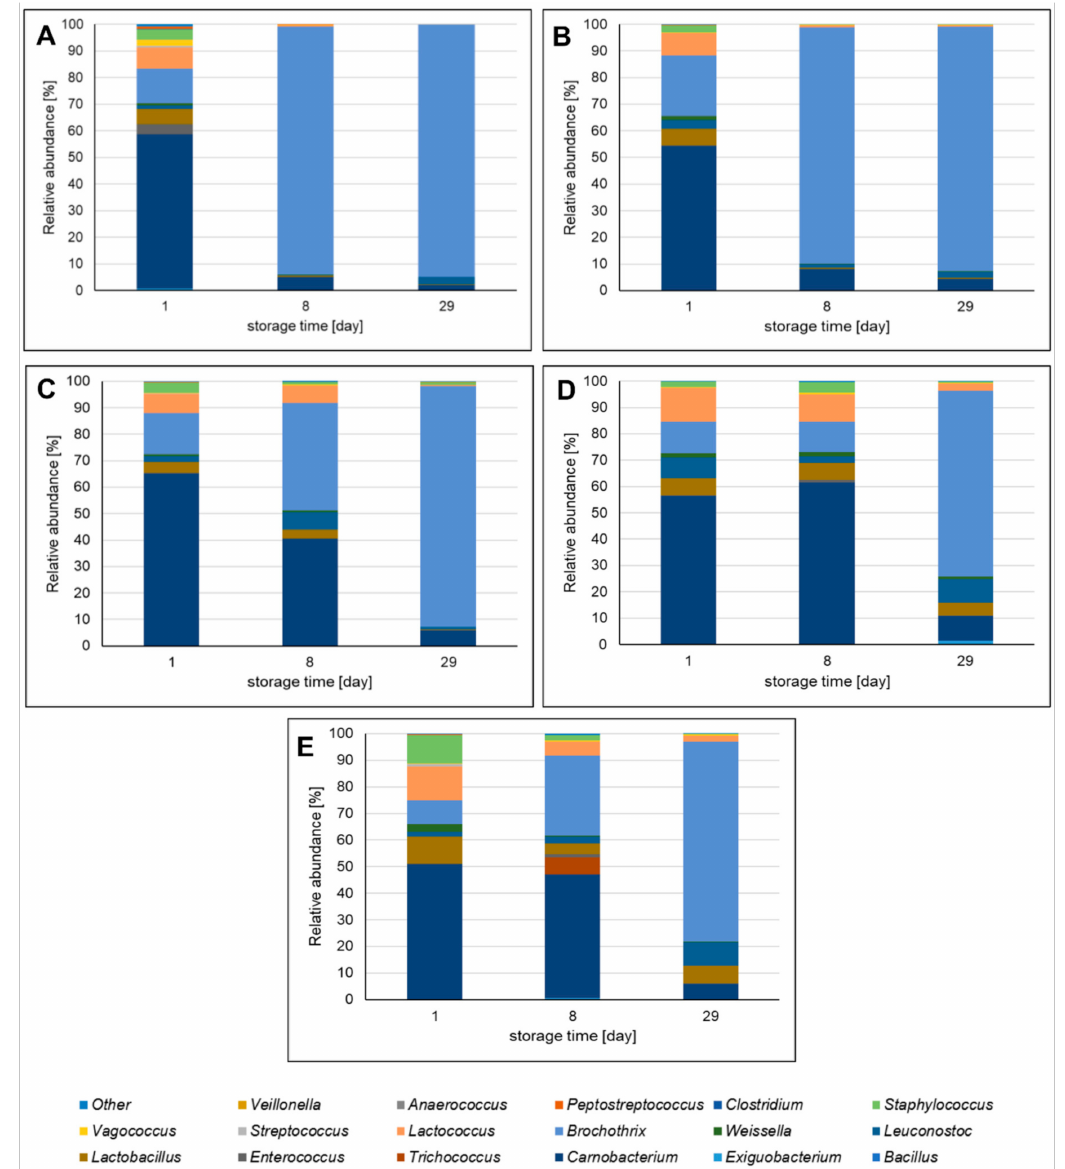
Figure 4. The most abundant genera among Firmicutes phylum identified in pork sausages stored in MAP at 4 ◦ C based on high-throughput sequencing of the 16S rRNA gene. The results are expressed as the percentage share of each bacterial genius making up the total number of identified genera in each sausage sample among Firmicutes phylum. Bacteria genera with percentage relative abundance >0.01% are shown. ( A )—sausage with Aronia melanocarpa leaf extract; ( B )—sausage with Chaenomeles superba leaf extract; ( C )—sausage with Cornus mas leaf extract; ( D )—sausage with curing salt containing sodium nitrate (III); ( E )—control sausage with salt and spices only (without extract and nitrates